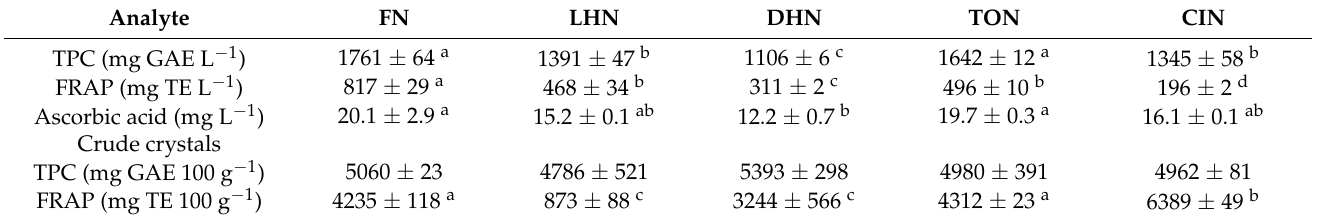
Table 4. Phytochemical composition and ascorbic acid content of the noni juice samples (n = 2 replicates for each sample). Different superscript letters in the same row indicate significantly different results according to post hoc Tukey testing at α =